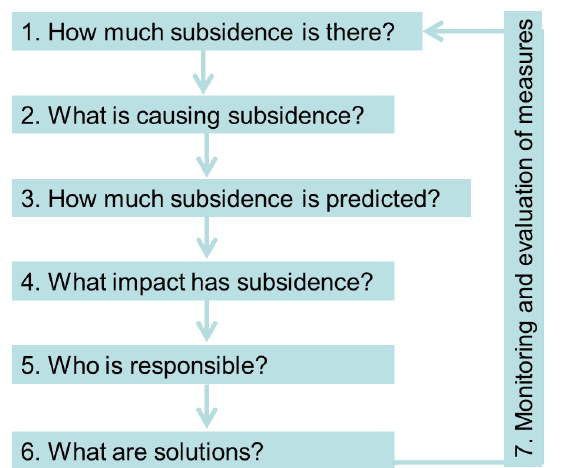
Figure 3. Seven questions that need to be addressed to pursue a suc- cessful policy to coop with subsidence. This is loosely based on the policy cycle, a popular framework to analyse policy